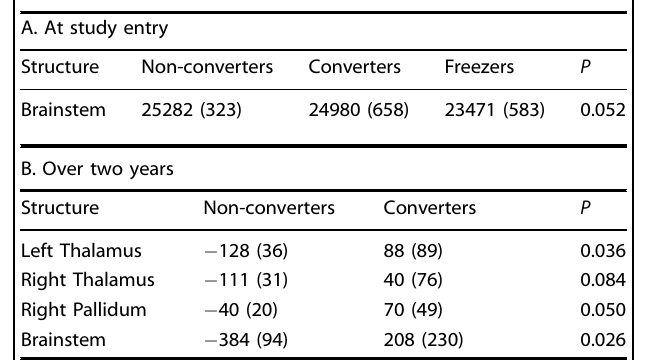
Table 2. Differences in global volumes of the subcortical